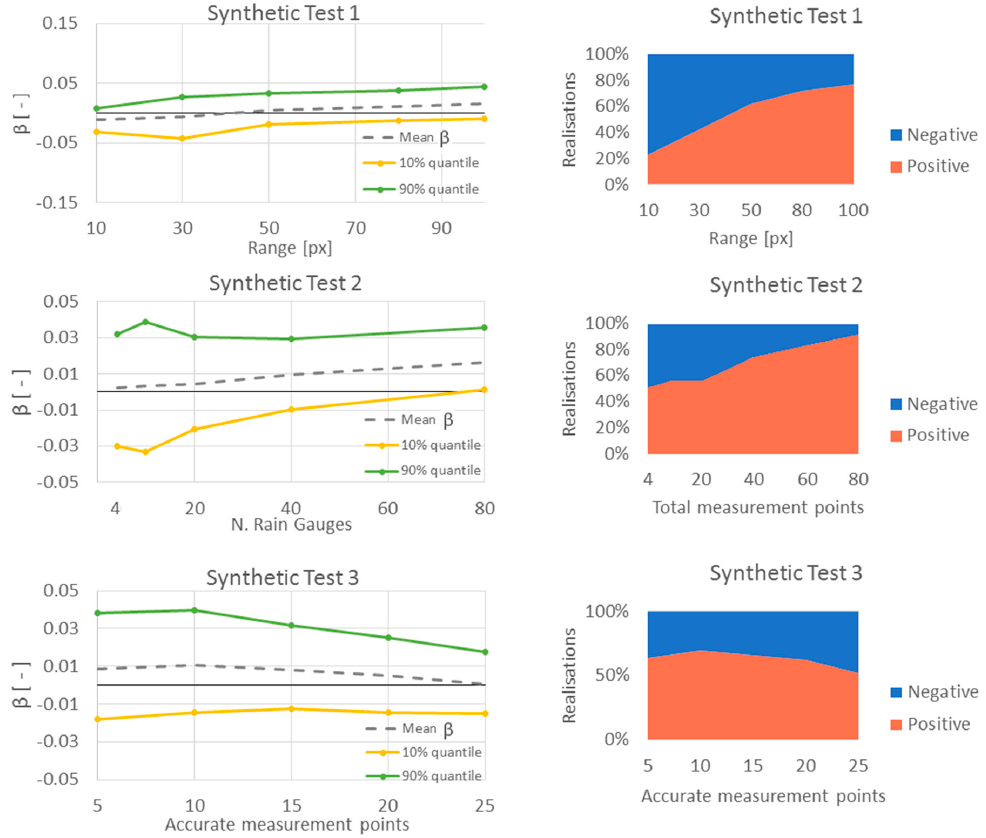
Figure 2. For each experiment, two plots are reported; the ones on the left show the mean, the 10% and 90% quantiles of the β values. The plots on the right show how many times OKUD outperforms OK (positive β ) and how many times instead OK outperforms OKUD (negative β ). For the Synthetic Test 3, only the number of accurate points is reported on the horizontal axis. Please note that the figure is from [41] as a shorter version of the work was presented at the EWRA conference 2017.